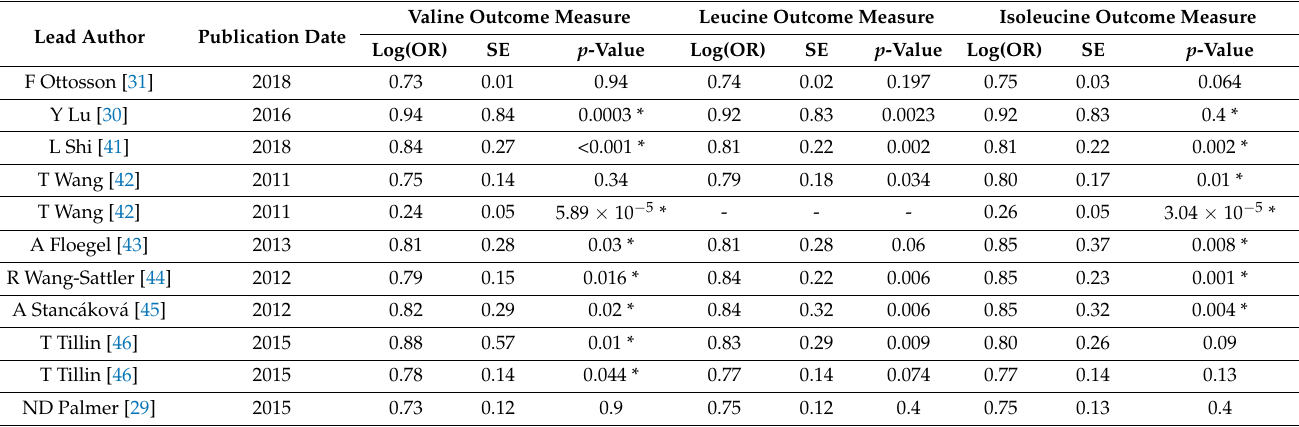
Table 2. Calculated log(OR) for individual serum BCAA levels per each data-point incorporated into the meta